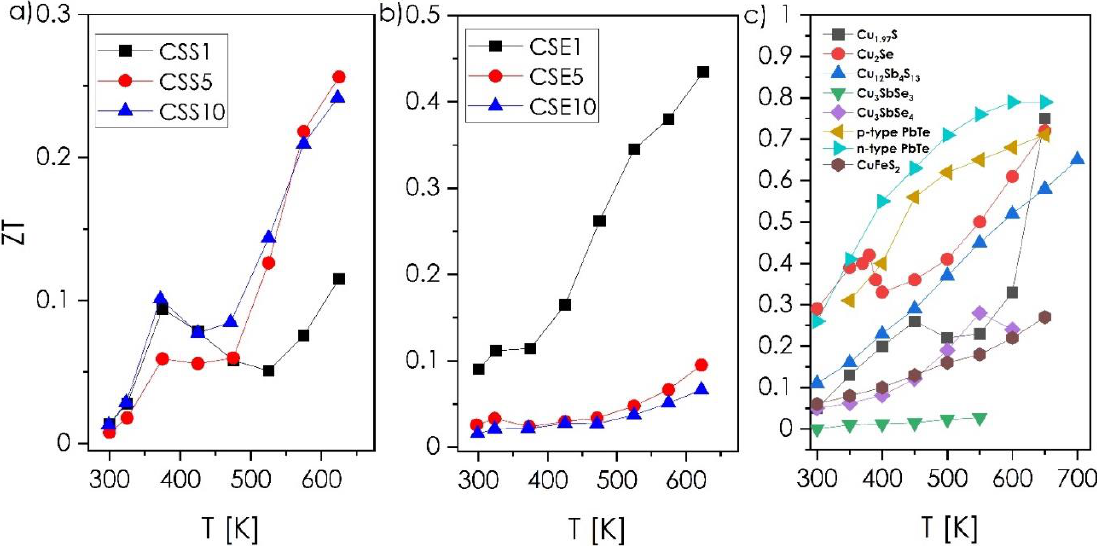
Figure 9. ZT—thermoelectric figure-of-merit parameter as a function of temperature determined for sulfur-rich ( a ), and selenium-rich composite ingots ( b ) in comparison to typical chalcogenide materials ( c ); [5,9,38–42] and references therein.